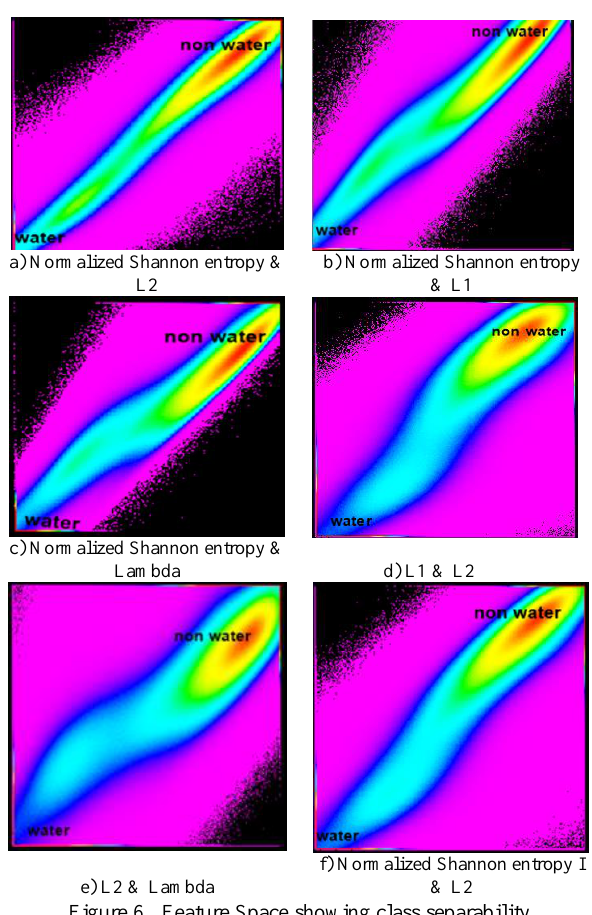
Figure 6. Feature Space showing class